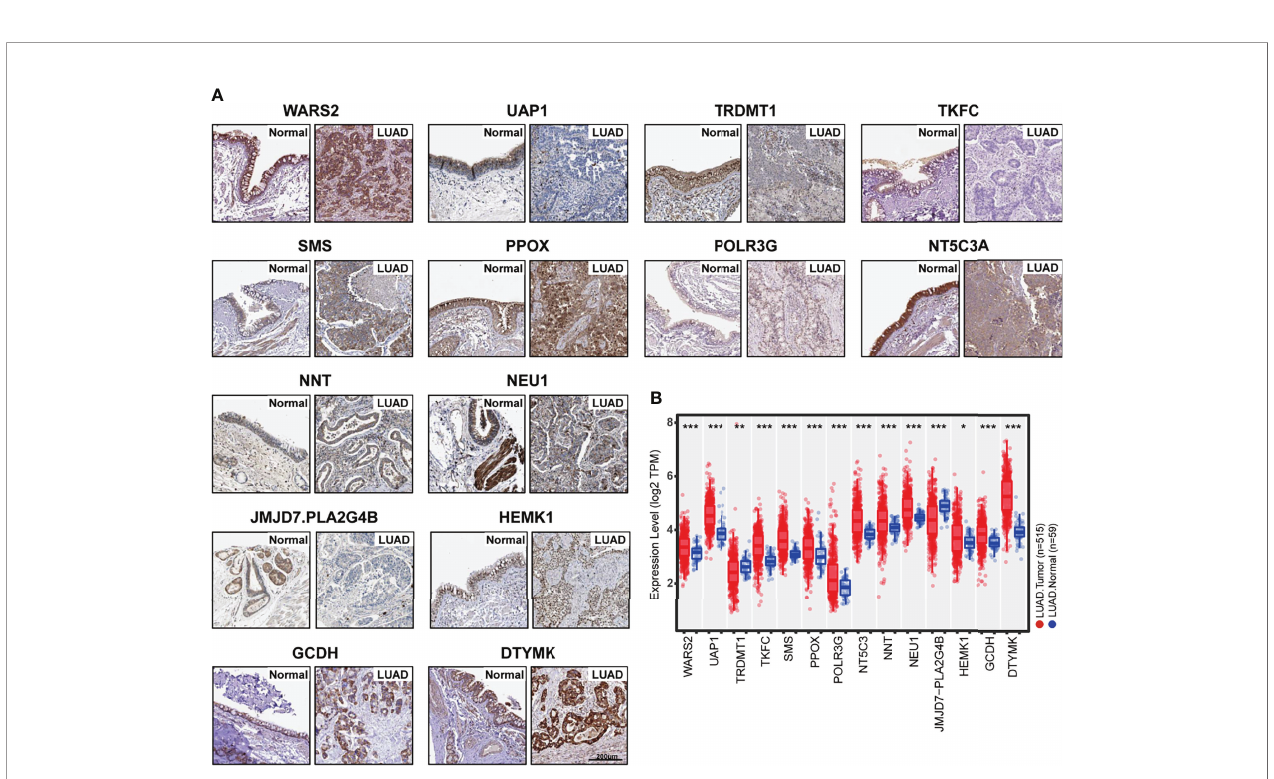
FIGURE 4 | Expression of 14 hub genes in normal and lung adenocarcinoma tissues. (A) Protein expression level and localization of 14 hub genes in normal bronchus tissue and lung adenocarcinoma specimens measured by IHC staining based on Human Protein Atlas (bars = 200 m m). (B) mRNA expression levels of 14 hub genes in normal (N=59) and lung adenocarcinoma (N=515) tissues were mapped with boxplots based on TIMER 20. and TCGA database. *p < 0.05, **p < 0.01 and ***p <